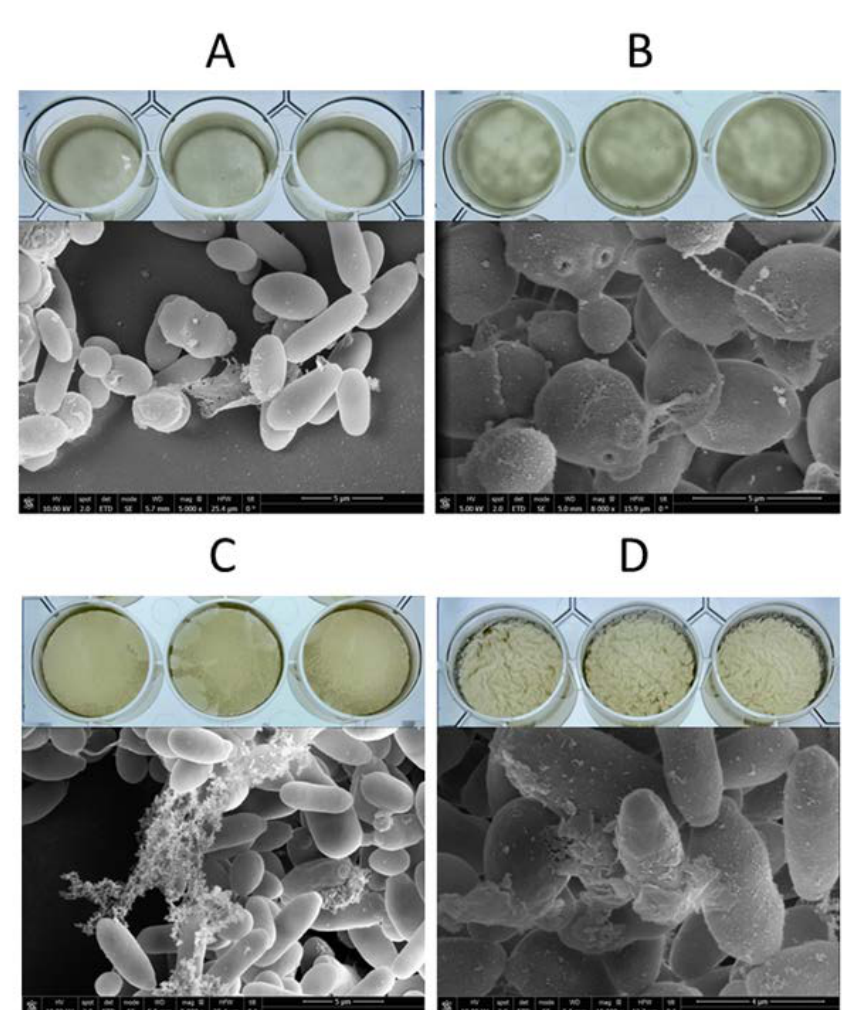
Figure 3. Flor yeast biofilm at a macroscopic level in base wine, and scanning electron microscopy of each biofilm formed by the non- Saccharomyces strains analysed: ( A ) W. anomalus ; ( B ) P. kudriavzevii ; ( C ) P. manshurica ; ( D ) P. membranifaciens .